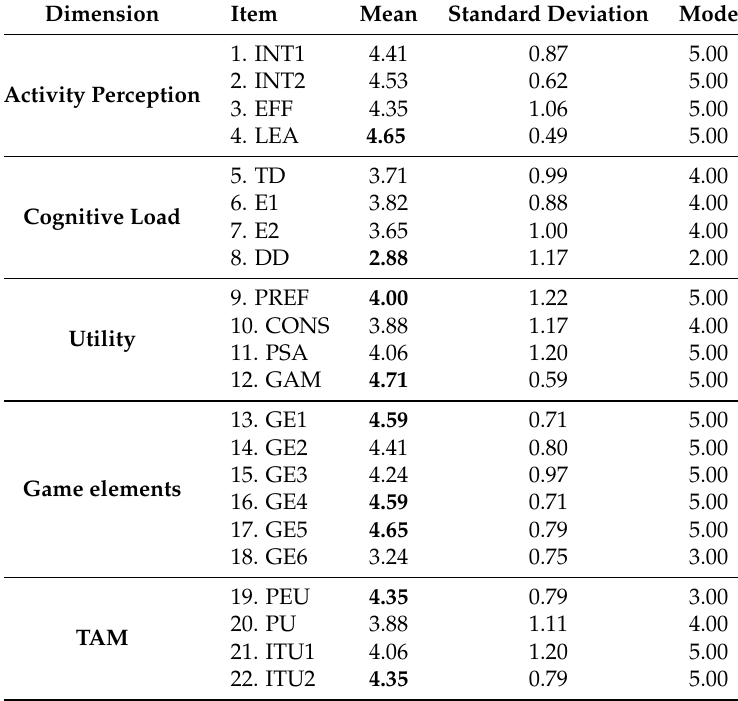
Table 1. Descriptive statistics of the dimensions evaluated by